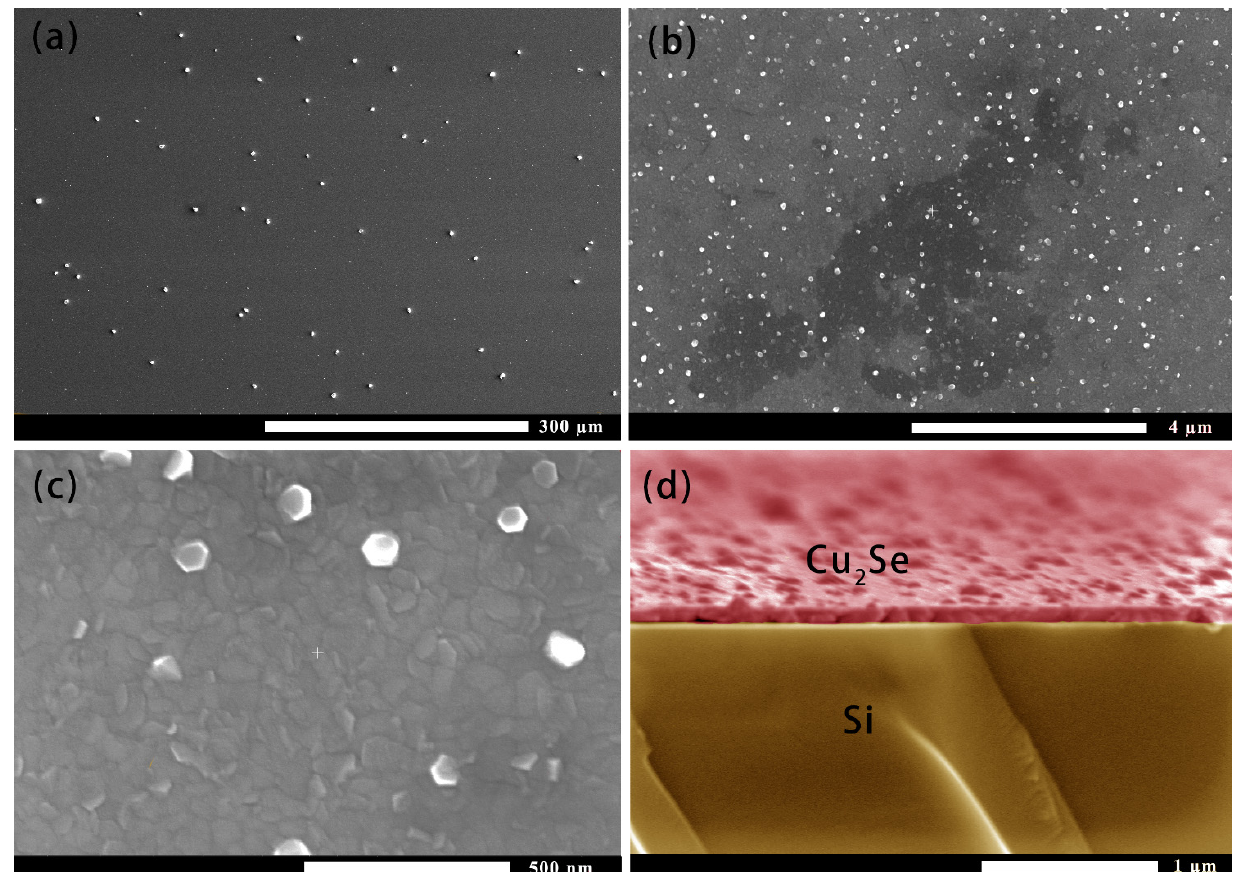
Figure 1. Scanning electron microscopic (SEM) image of the surface of the film. ( a – c ) Surface topography at different magnifications. ( d ) False cross-sectional SEM analysis of the film on Si substrate.